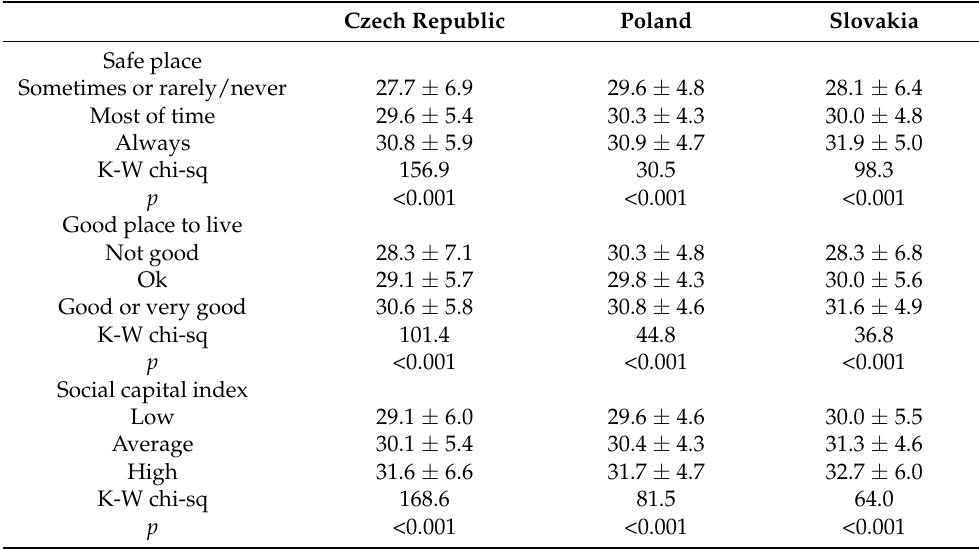
Table 3. Mean health literacy by neighbourhood social features mean ± SD.